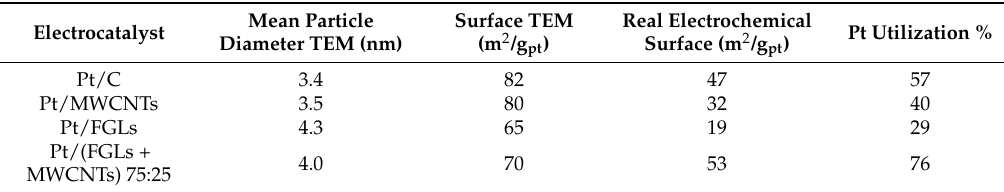
Table 2. Comparison of the particle diameter (TEM), calculated particle surface (STEM), ECSA (RDE) and the Pt utilization percentage of the employed